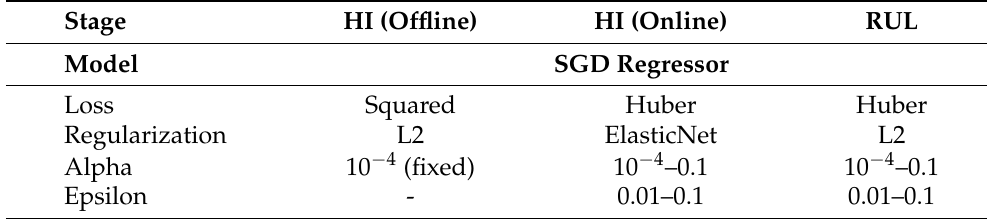
Table 4. Parameter range for each